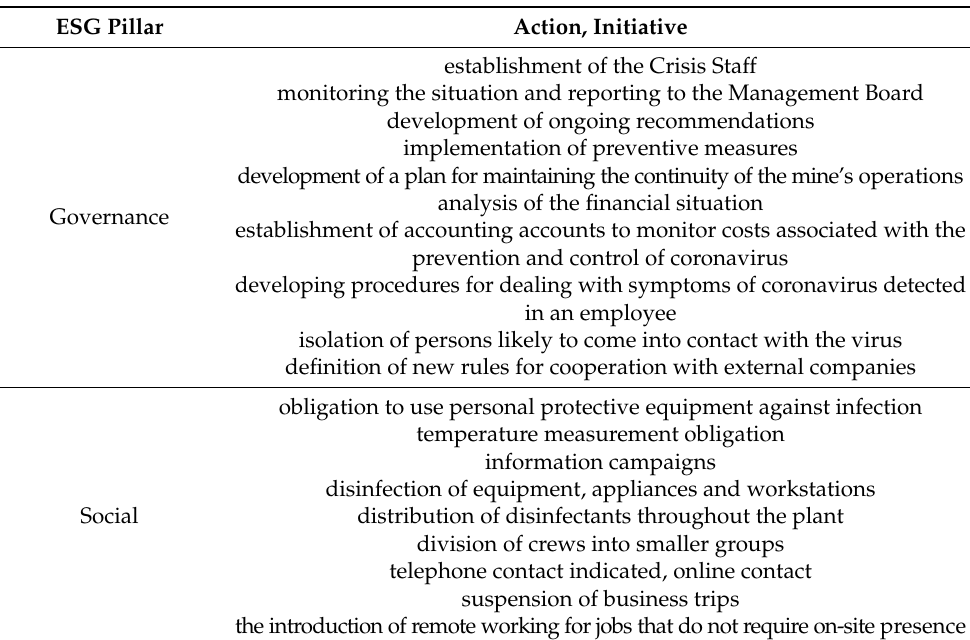
Table 1. Actions and initiatives taken by LW Bogdanka S.A. during the pandemic period. ESG